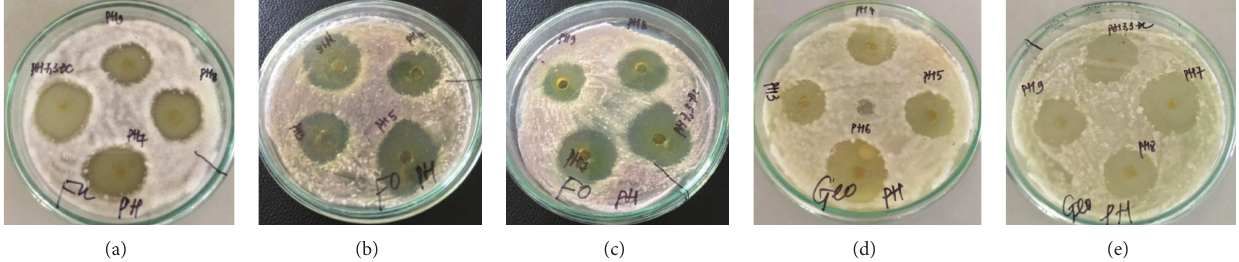
Figure 6: Well diffusion assay for stability to pH of the antifungal substance. (a) F. udum , (b, c) F. oxysporum , and (d, e) G. candidum .